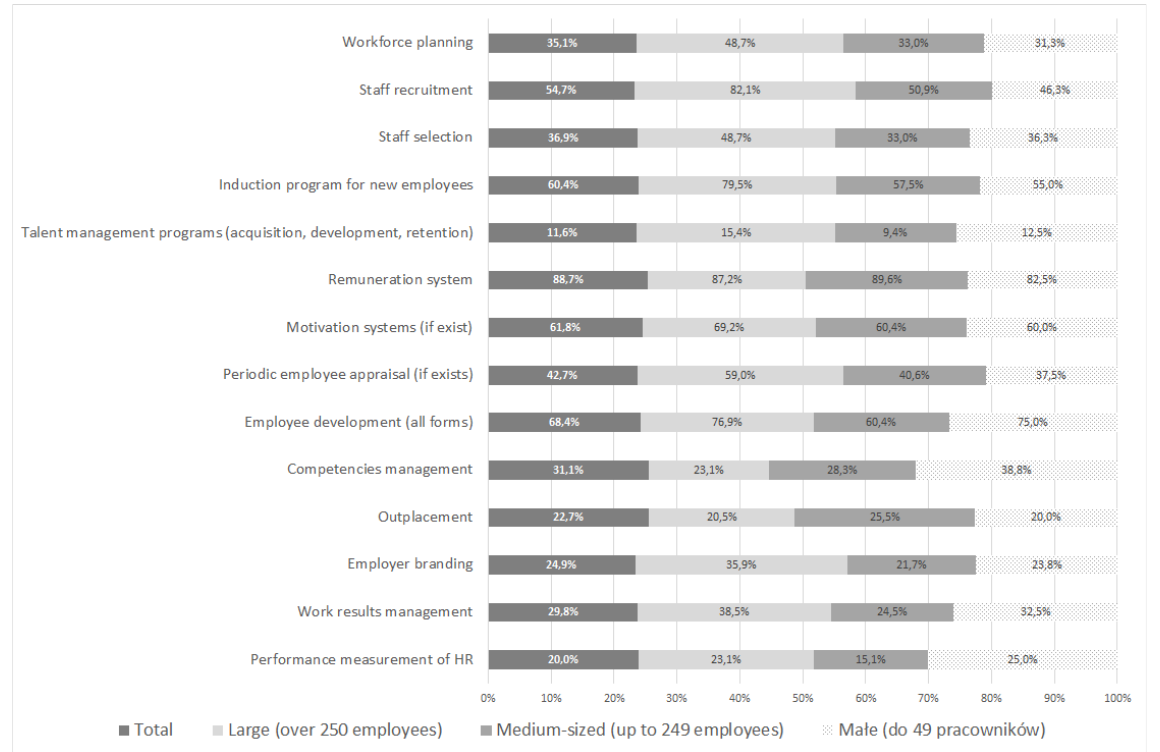
Figure 5. HR procedures performed in the surveyed firms. Source: author’s original work .